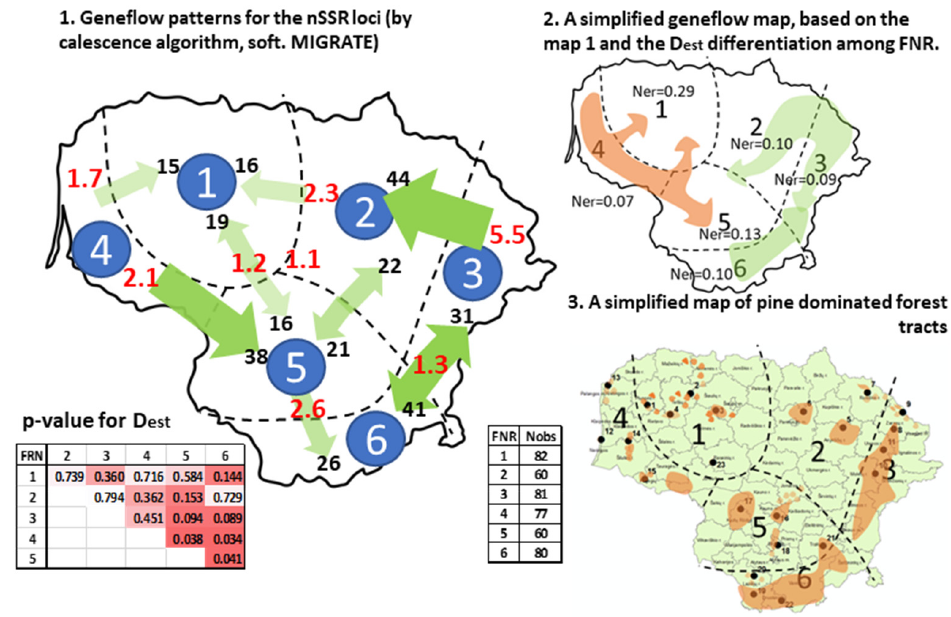
Figure 2. Geneflow patters among Scots pine populations in different FNRs for the nSSR data, based on the coalescence algorithm implemented in MIGRATE_N software. In Map 1 , the arrows show incoming/outgoing migrant ratios per generation (the red numbers at the arrow basis) and strength (arrow width and color saturation) among the FNR (ratio = number of incoming/outgoing migrants, whereby the ratios close to 1 indicate a balance among out-and-in-going migrants, ratios >1 indicate more incoming migrants than outgoing into the FNR pointed by the arrow, e.g., ratio of 2.1 means there were twice as many incoming than outgoing migrants from FNR 4 to 5). The black numbers at the arrow tips are migrant numbers per generation. Map 2 . A simplified gene-flow pattern from map 1 indicates the trends, where the ratios of effective population size of whole FNR over the census number in each FNR are given as well. Map 3 . The main Scots pine forest tracts and sample populations are marked by dots (sample size in each FNR at the bottom of map 3). The tables below Map 1 shows the pairwise p-values for the D est differentiation test among FNR (left) and sample size in each FNR (right).